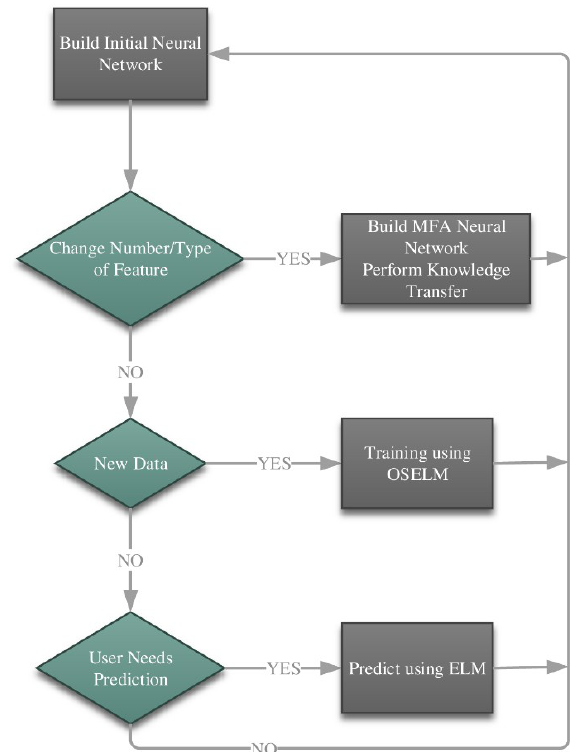
Figure 2. General procedure for the maximum feature adaptive online sequential extreme learning machine (MFA-OSELM) algorithm.